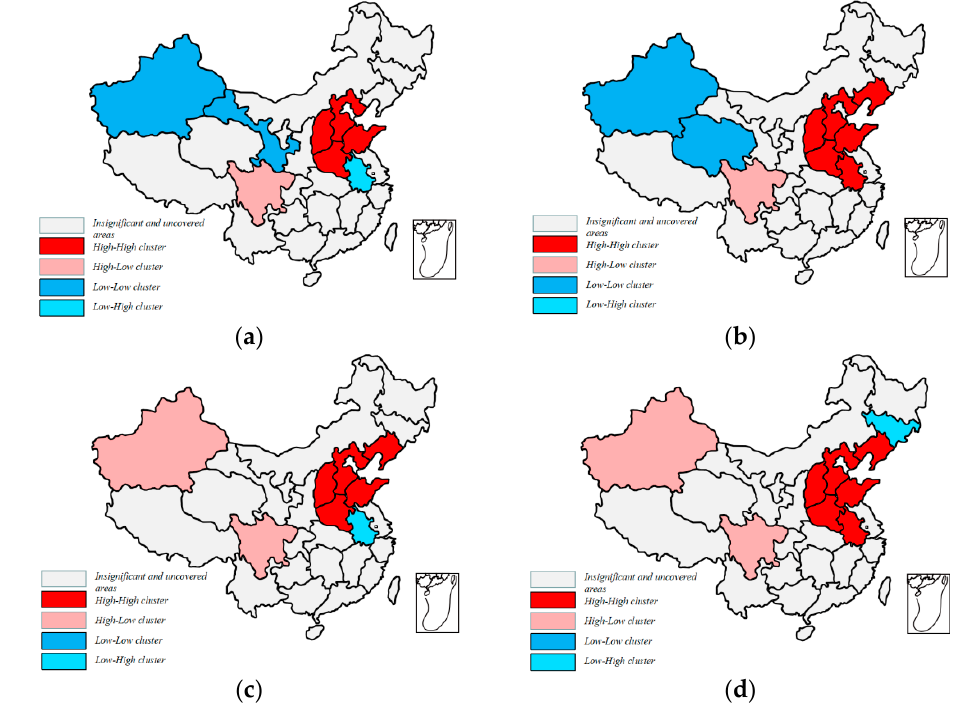
Figure 2. LISA cluster map of pollution in China for the years: ( a ) 2000; ( b ) 2008; ( c ) 2013; ( d ) 2017. (Note: The LISA cluster map of environmental pollution was analyzed by Geoda (Dr. Luc Anselin) software.).